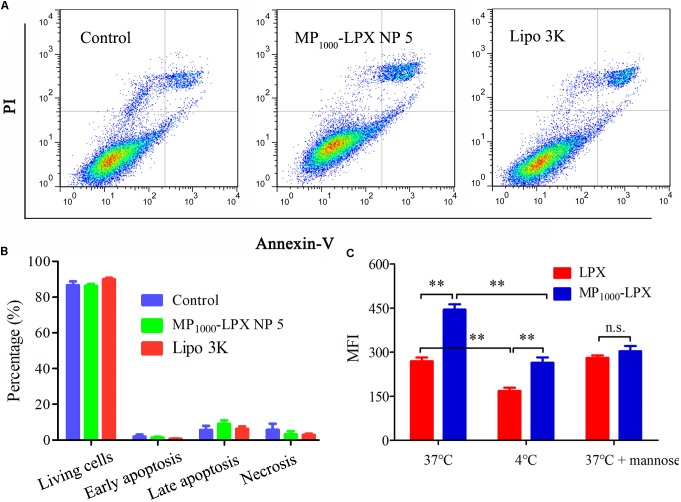
Cytotoxicity and uptake assay of MP1000-LPX on DC2.4 cells. (A,B) Flow cytometry measurement of cell apoptosis induced by MP1000-LPX NP 5 and Lipo3K on DC2.4 cells. The data showed mean ± SEM from a representative experiment from three independent experiments. (C) Cellular uptake mediated by mannose receptor at different conditions, including incubated at 4, 37, or 37°C with free mannose. ∗p < 0.05; ∗∗p < 0.01.